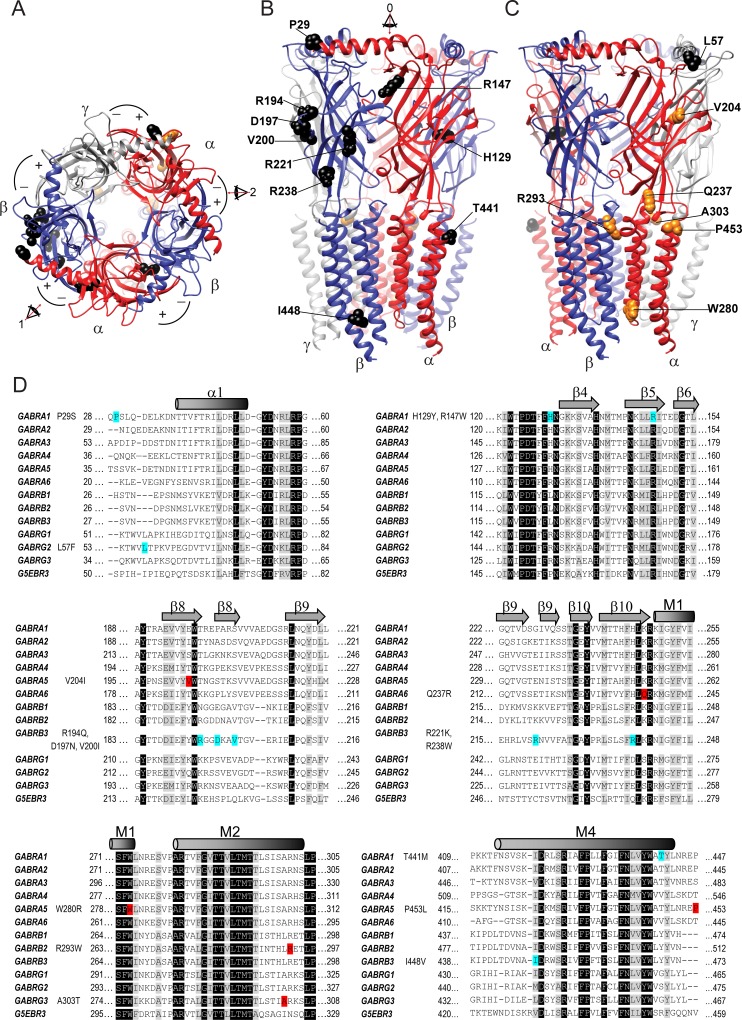
Mapping of GABR variants on the GABAA receptor.(A), 3-D structural model of the GABAA receptor rendered with subunits arranged in a γ-β-α-β-α counter clockwise sequence as viewed from the synaptic cleft. The principal (+) and complementary (-) interfaces of each subunit are shown with the β subunits in blue, α subunits in red and γ subunit in grey. Eye arrows 1 and 2 at the β+/α- interfaces match the view of the models in panels B and C, respectively. (B, C), show side views of the full-length pentameric receptor structure at the β+/α- subunit interfaces mapping GEC (orange) and ESP (black) GABR variants. Eye arrow 0 indicates the view of the 3-D model in panel (A). (D) Multiple sequence alignment of GABR genes and the solved GluCl crystal structure (G5EBR3) as a reference for structural domains of the GABAA receptor. Locations of variants are highlighted in red for GEC and blue for ESP subunit variants. Secondary structures are indicated across GABR genes above the alignments, identical residues are highlighted in black and conserved residues in light grey. Each panel represents the succession in the sequence alignment where variants were found. Variants located in the signal peptide and M3/M4 cytoplasmic loop domains are not included.